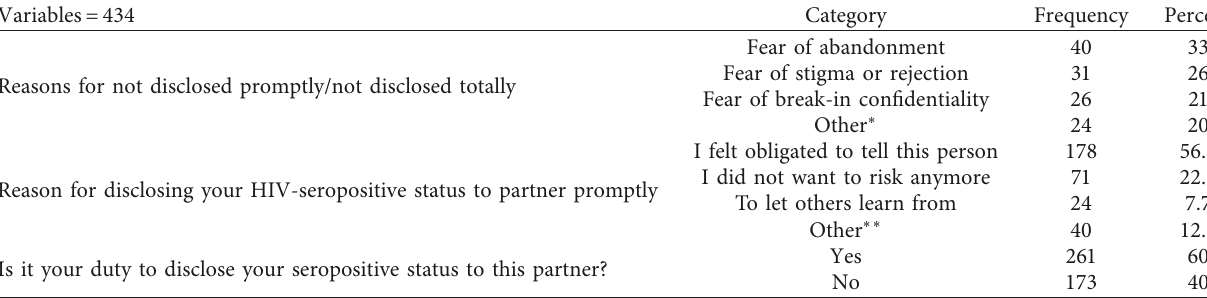
Table 3: Reason for disclosure and nondisclosure by the client on ART at Holeta Health Center, central Ethiopia, 2020. Variables � 434